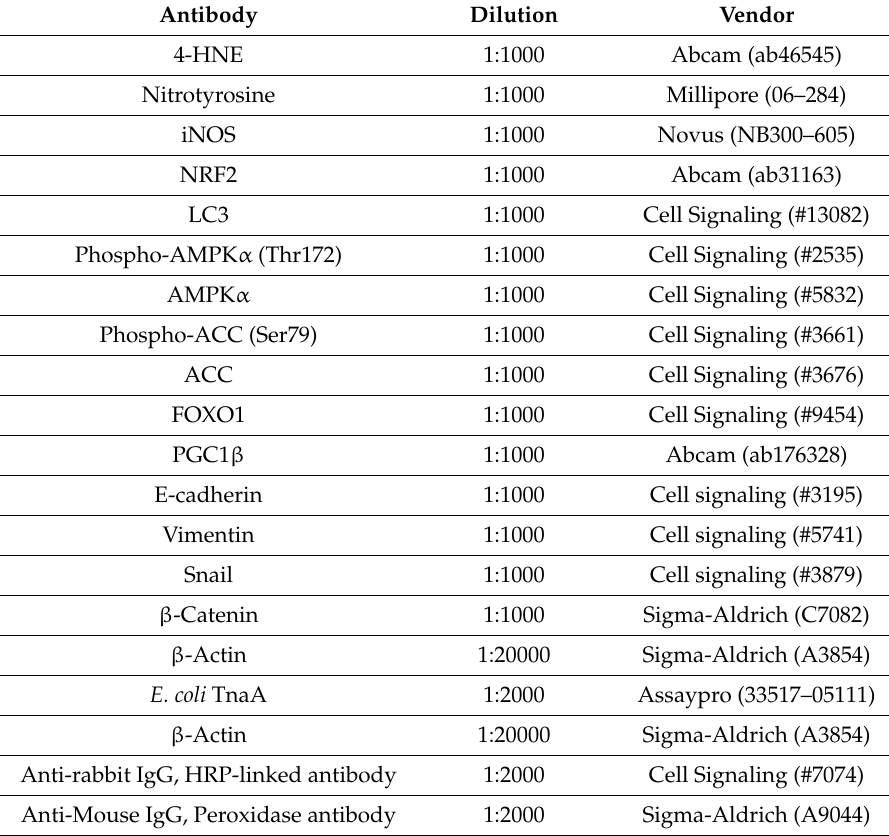
Table 3. List of antibodies used for Western